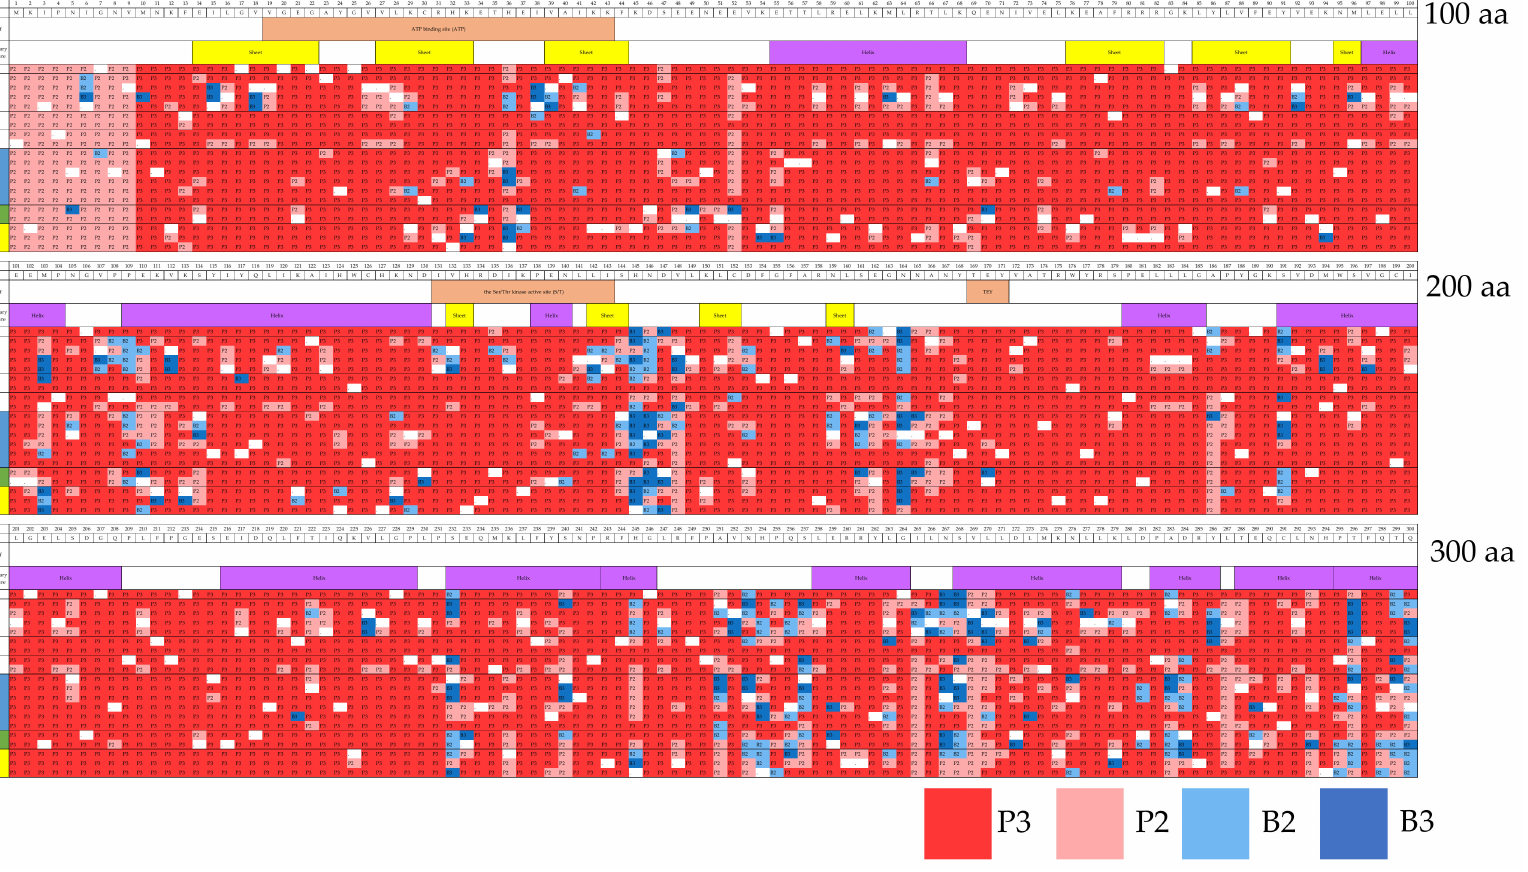
Figure 2. Heatmap of integrated in silico prediction data from PolyPhen-2 (HumDiv), PolyPhen-2 (HumVar), and PROVEAN analysis. The criteria for judgment were indicated in Table 2. There were 94.0% pathogenic mutations and 6.0% benign mutations out of 5700 mutations. Amino acid sequences are shown at the top of the table, where amino acids were divided into non-polar and polar amino acids, polar amino acids, those without acidity (blue), as well as acidic amino acids (green), and basic amino acids (yellow). Wild-type (WT) amino acids such as M1M, K2K, I3I, . . . were indicated “.” And colored in white. The mutation judgments P3, P2, B2, and B3 are shown in the smallest square. aa; amino